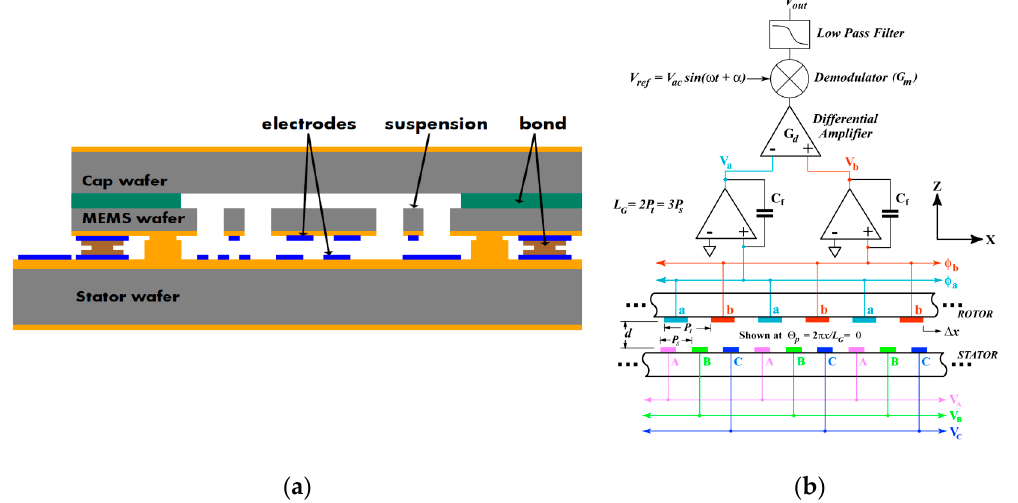
Figure 10. Schematic diagrams of the Hewlett Packard MEMS accelerometer and its sensing scheme: ( a ) schematic cross-section of the MEMS accelerometer [46]; ( b ) HP’s three phase capacitive sensing electrode arrangement.